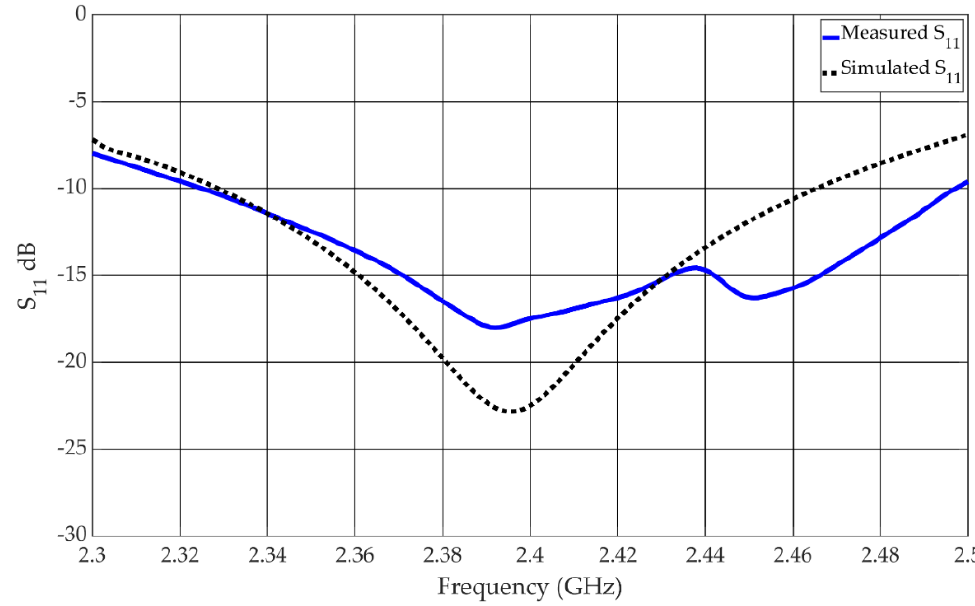
Figure 7. Measured and simulated reflection coefficient of the antenna in the circular state.